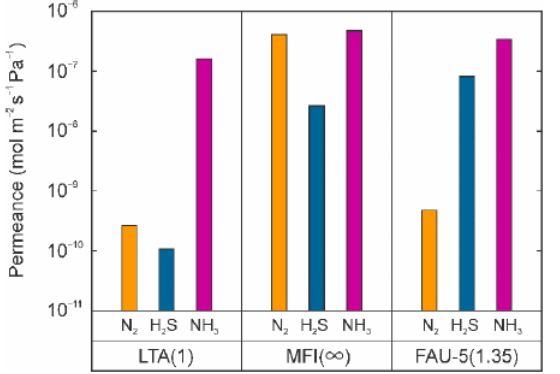
Figure 6. Effect of crystal structure of zeolite on gas permeation properties of membranes for ternary mixtures of NH 3 , H 2 S, and N 2 at 295